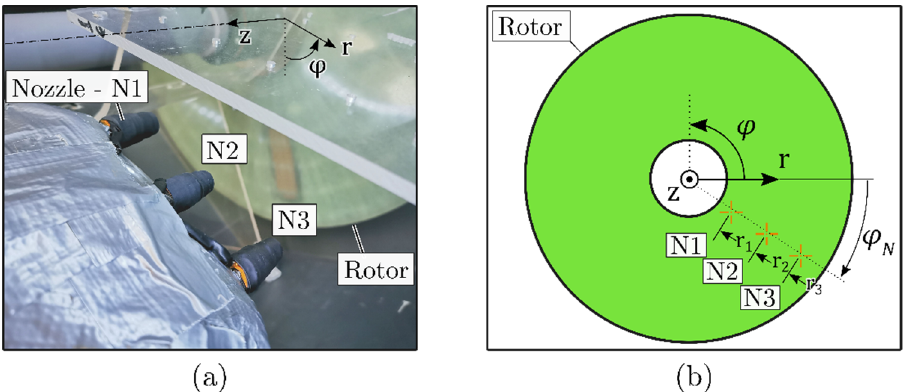
Figure 3. Picture of the nozzle setup on the test bench ( a ) and the corresponding schematic illustration Figure3. Pictureofthenozzlesetuponthetestbench( a )andthecorrespondingschematicillustration( b ( b ).